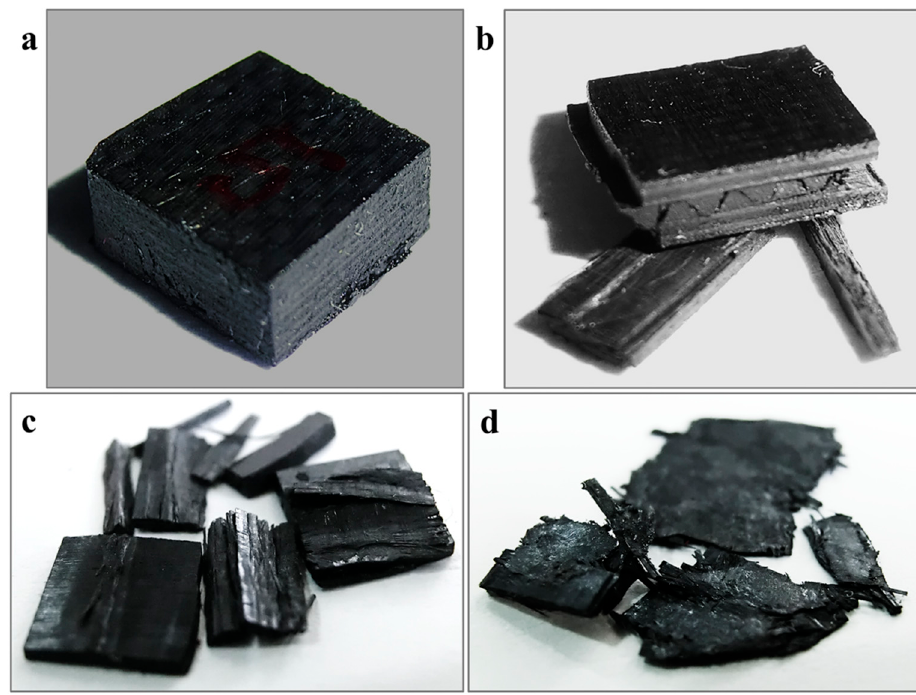
Figure 8. Macrostructure morphologies of (0°/90°) 5 AS4/PEEK laminated composite after out-of-plane dynamic compression at different strain rates. ( a ) Specimen A5-1489/s. ( b ) Specimen A4-1832/s. ( c ) Specimen A2-3866/s. ( d ) Specimen A1-6848/s.